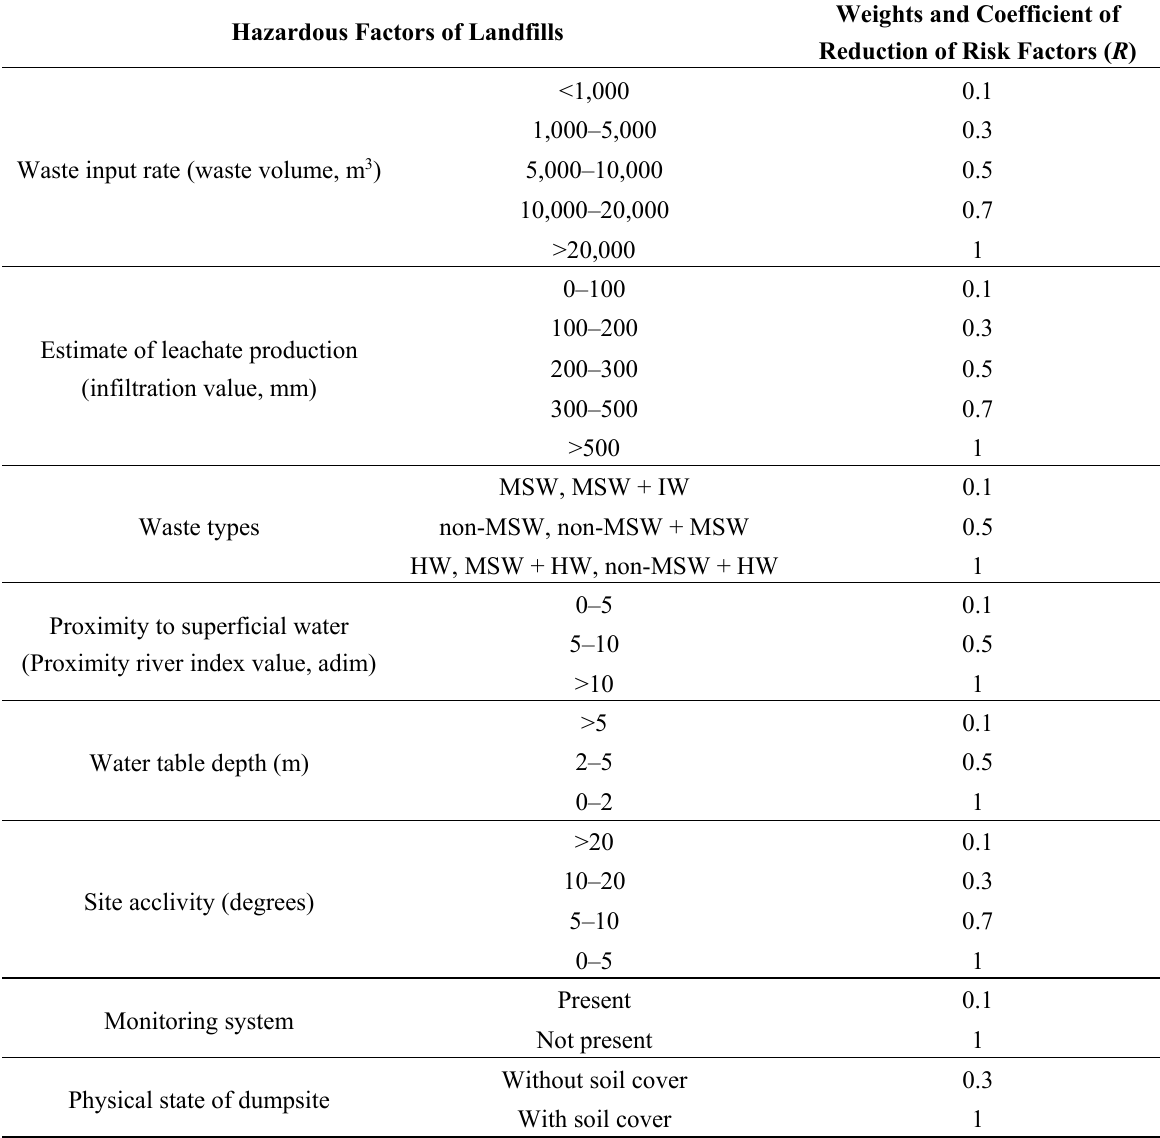
Table 1. Scores and coefficients of reduction (weights) of the considered risk